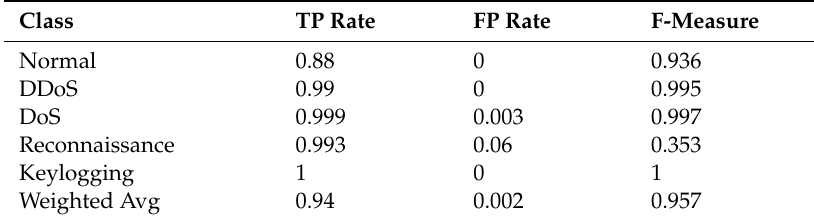
Table 13. Detailed accuracy of using stage